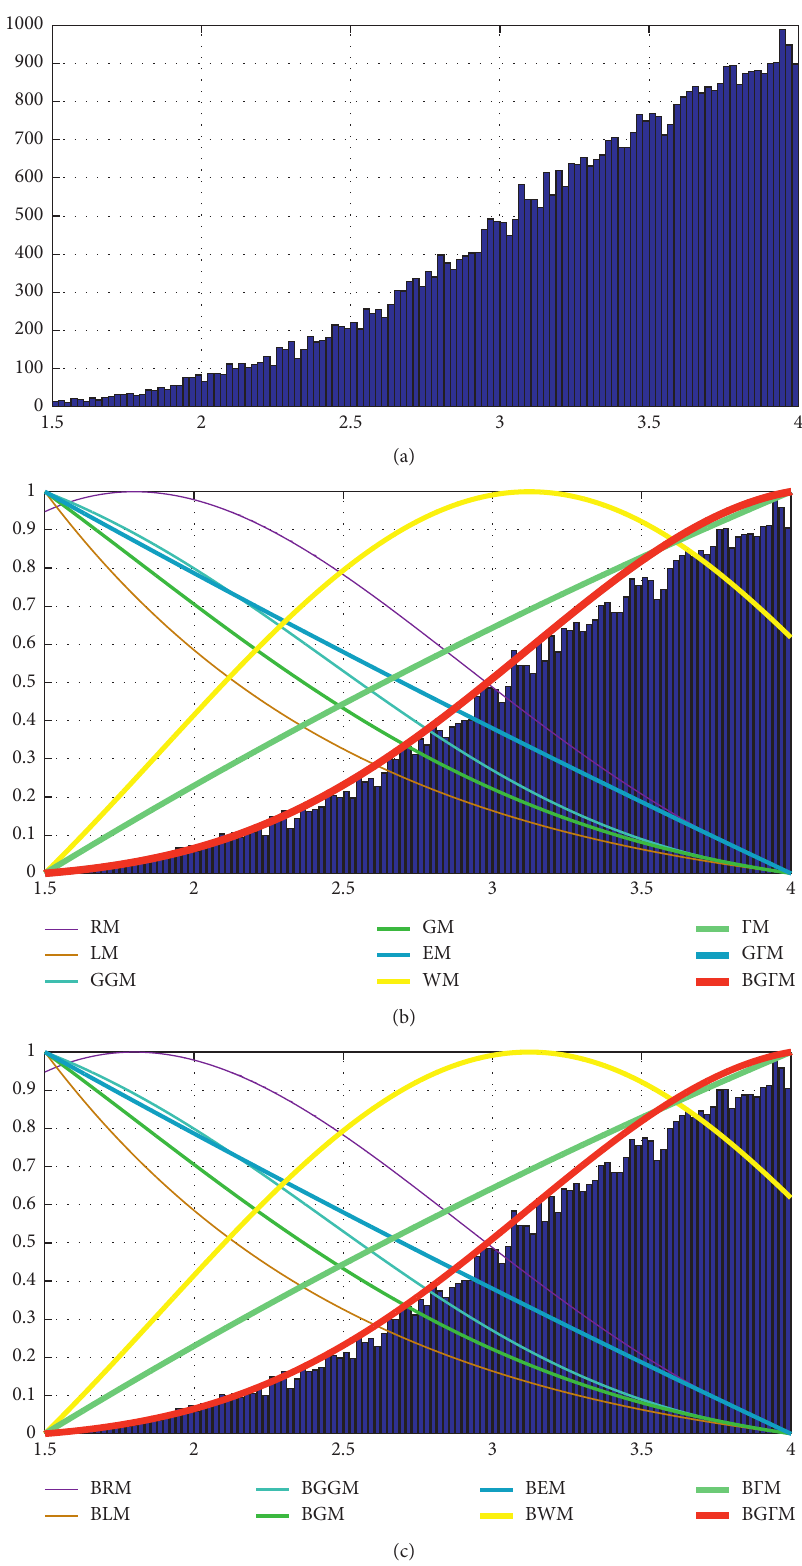
Figure 4: The estimated histogram (a) the histogram of the observed data with u � 0 . 3; δ � 1 . 5; η � 2, λ � 3 and β � 0 . 1 in the interval ( 1 . 5 , 4 ) ; (b) the estimated histogram of RM, LM, WM, GM, EM, GGM, Γ M, G Γ M, and G Γ M; (c) the estimated histogram of BRM, BLM, BWM, BGM, BEM, BGGM, B Γ M, and BG Γ